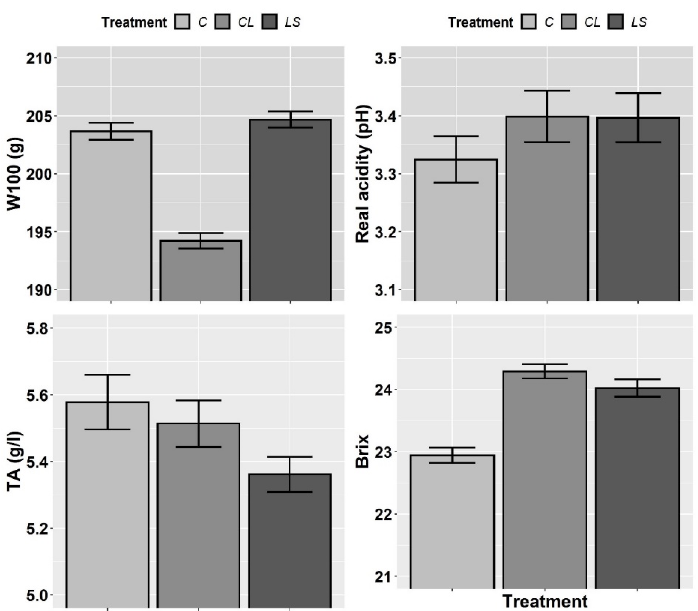
Figure 7. Mean values of the harvest parameters (weight of 100 grape berries (W100), real acidity (pH), titratable acidity (TA) and Brix degrees (Brix)) for each treatment. Treatments: control (C), control of leonardite (CL), and leonardite mixed with ferrous sulphate heptahydrate (LS). Error bars reflect the SE of the mean (±1 SE mean).